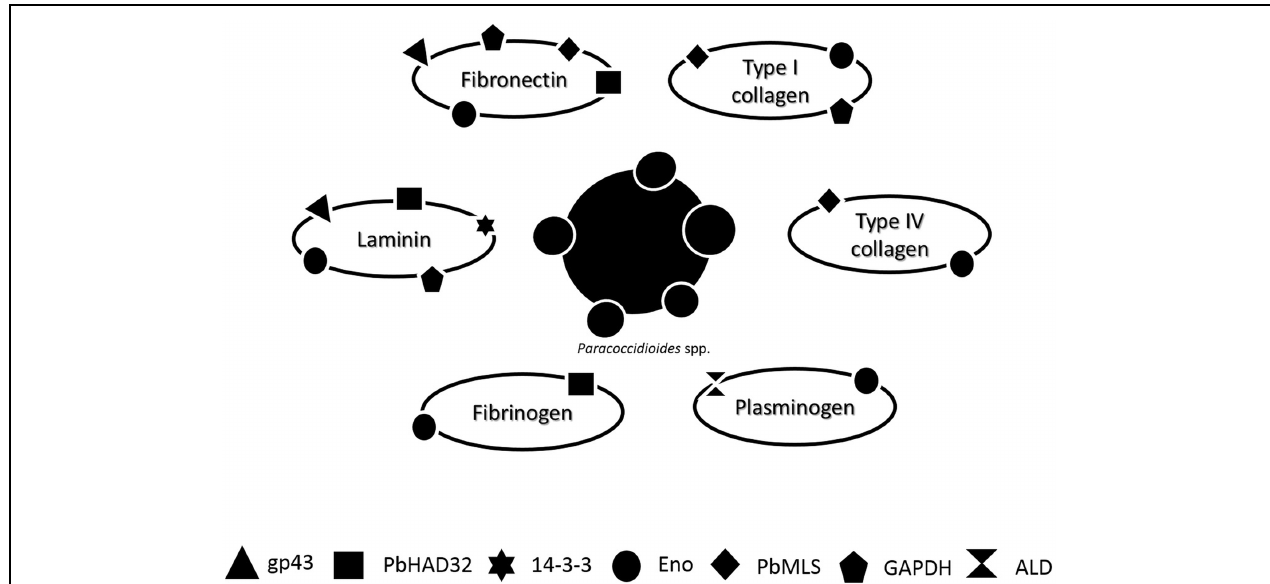
FIGURE 1 | Schematic representation of the affinity of different Paracoccidioides spp. adhesin [gp43, hydrolase (PbHAD32), 14-3-3, Enolase (ENO), Malate synthase (MLT), glyceraldehyde 3-phosphate dehydrogenase (GAPDH), and 1,6 bisphosphate aldolase (ALD)] to different ECM components: laminin, fibronectin, type I collagen, type IV collagen, plasminogen, and